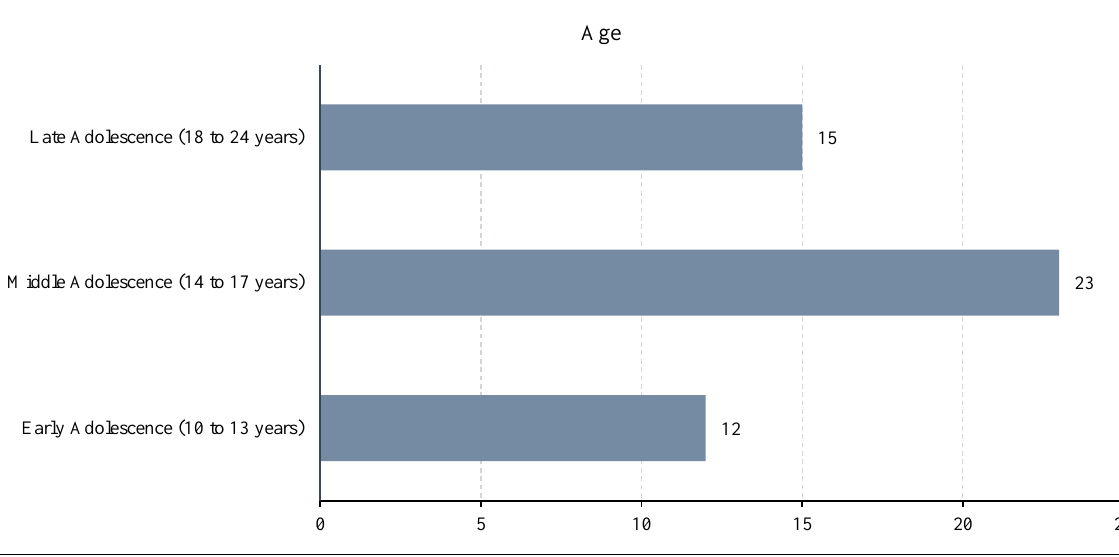
Figure 4. Age of the